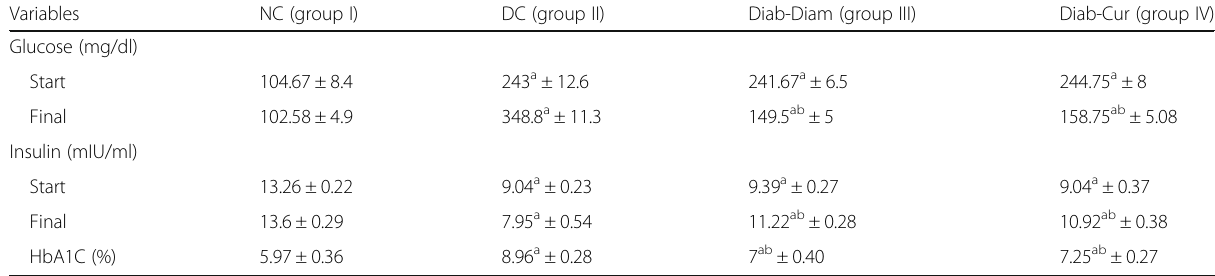
Table 1 Effects of nano-curcumin and Diamicron on glucose, insulin, and glycated hemoglobin of Streptozotocin-induced diabetic